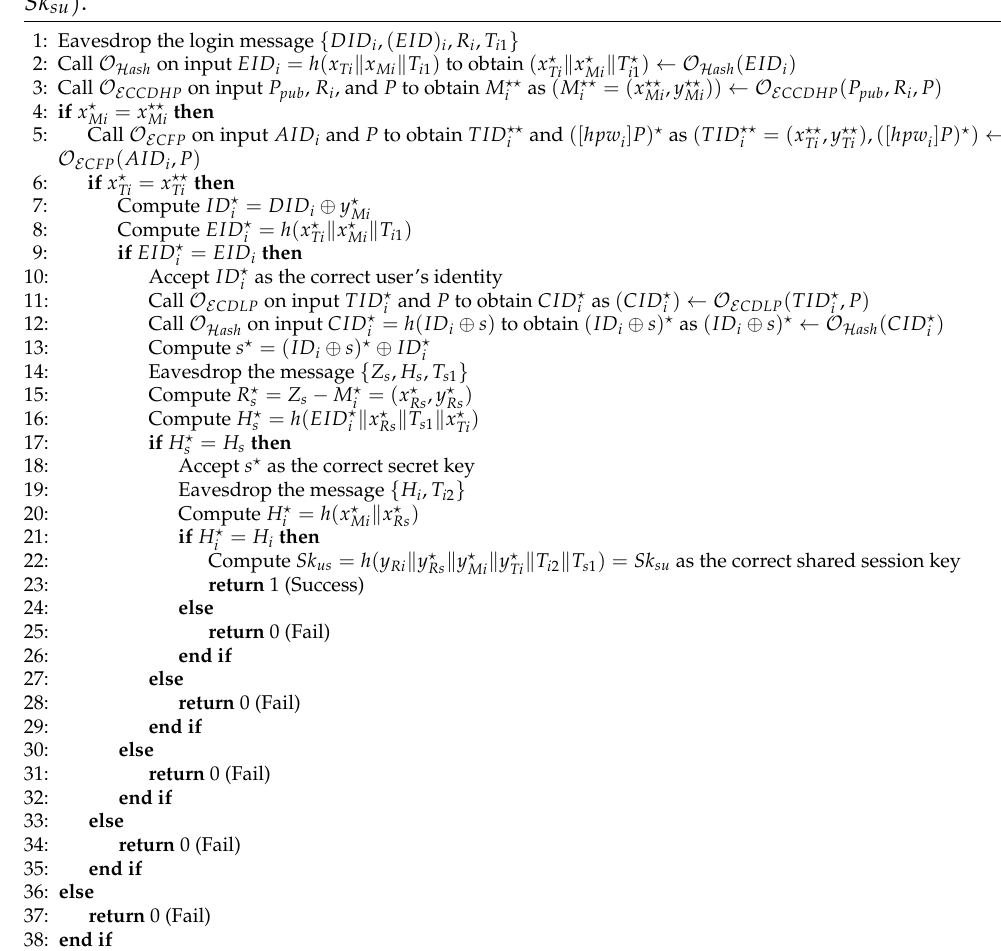
Algorithm 1 ALG O racle A for deriving identity ID i , secret key s , and session key Sk us (= , ECPAS Sk su )